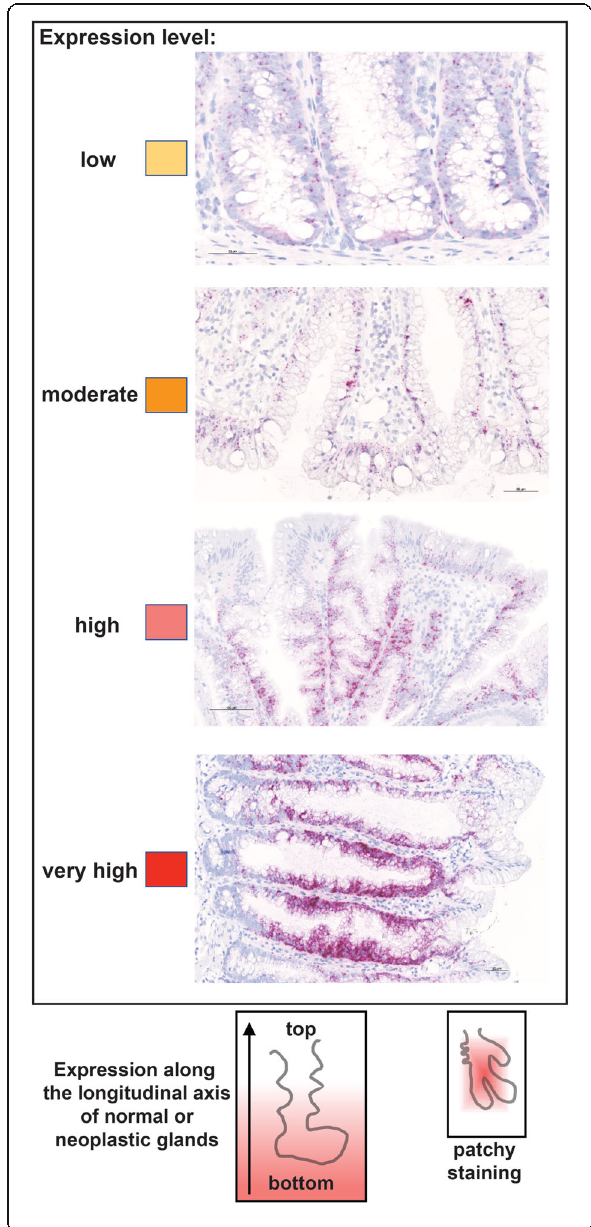
Fig. 1 RNA-expression scoring of colorectal tissue sections. Intensity and distribution of epithelial cell expression of target RNAs were assessed in the entire section. IHC staining intensity was classified as low , moderate , high, or very high based on the number and size of dots and dot aggregates in the epithelial cells. Each score is color- coded according to the yellow-to-red scale used in Table 1. ISH staining distribution patterns were classified as shown in the schematics at the bottom of this figure: ( left ) staining distributed along the entire length of the longitudinal axis of normal and neoplastic glands, from the bottom to the luminal portion, in regions of the section where the specimen was properly oriented; ( right ) “ patchy staining ” consisting of stained and unstained regions within the same section, which is depicted as a rectangular gradient fill whose area is proportional to the prevalence and size of the stained patches across the section. Both staining distribution features are also depicted in Table 1 for each RNA. Distribution of staining along the longitudinal crypt axis was generally more common in normal mucosa, HPs, and SSLs (well-oriented specimens of flat or slightly elevated lesions); patchy staining patterns were found mainly in polypoid cADNs and TSAs, whose thick epithelium often contains intricately-folded, dysplastic